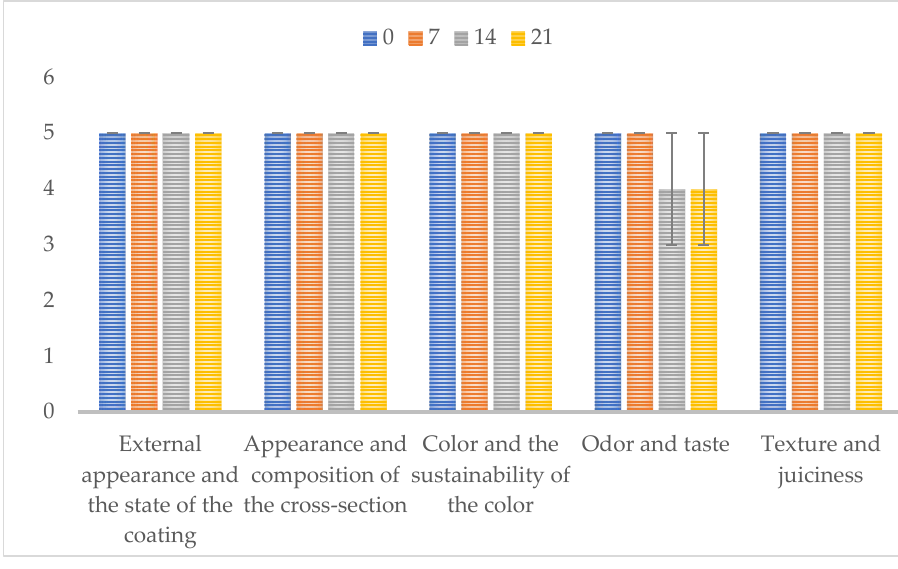
Figure 1. Sensory properties of traditional goat cheese during